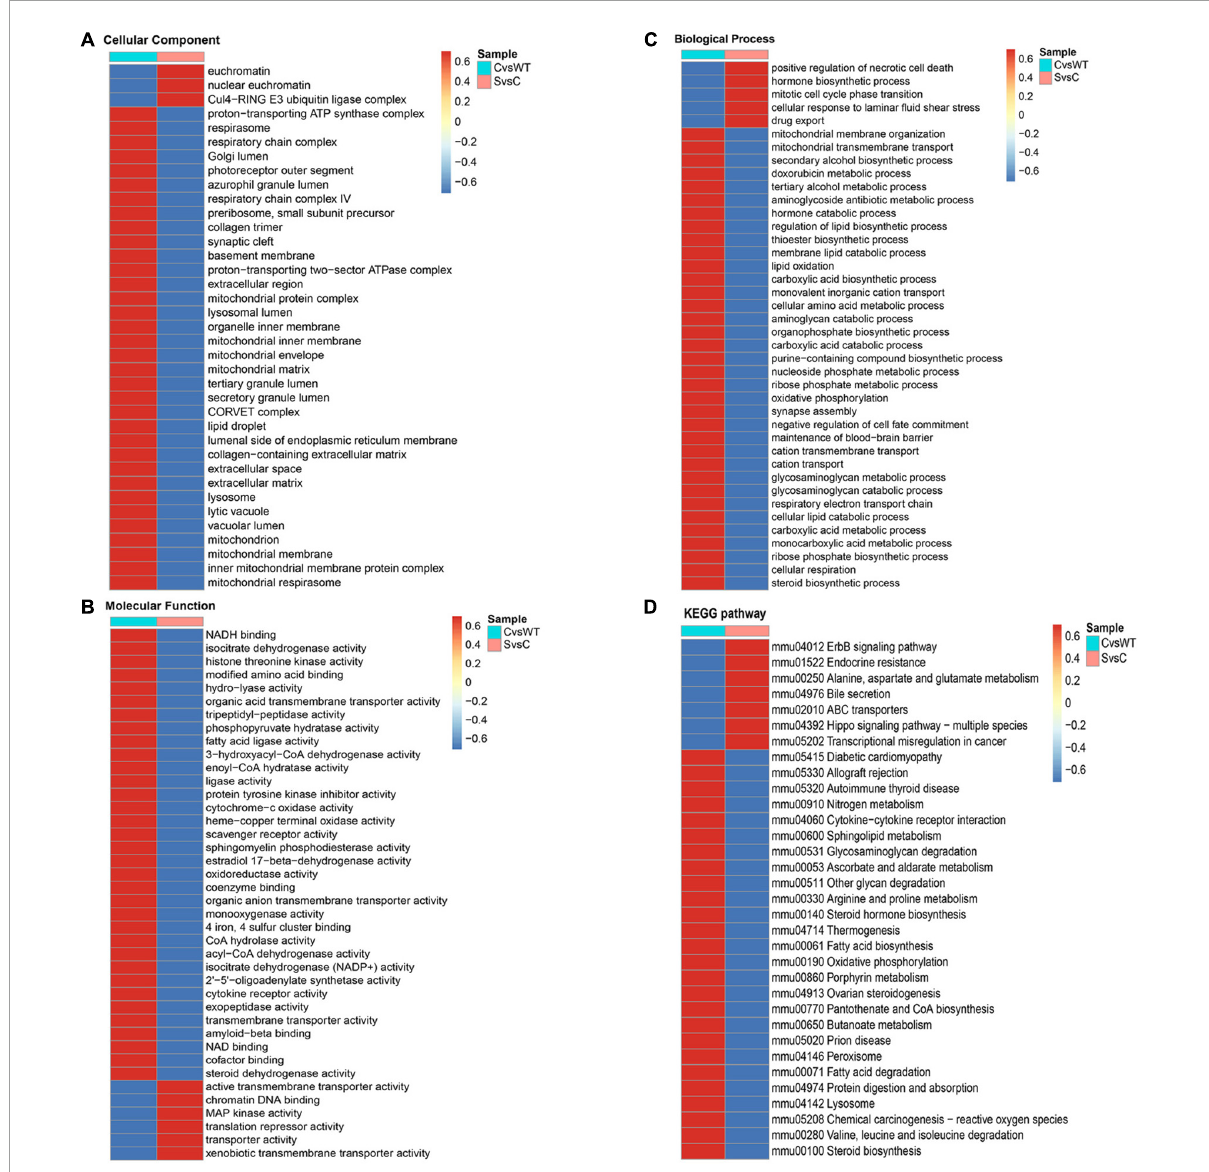
FIGURE7 GO enrichment cluster analysis and KEGG pathways cluster analysis of differentially expressed proteins (DEPs) between C/WT and S/C group. (A) GO enrichment cluster analysis of DEPs based on cell component. (B) GO enrichment cluster analysis of DEPs based on molecular function. (C) GO enrichment cluster analysis of DEPs based on biological process. (D) KEGG pathway enrichment cluster of DEPs. WT, NSC34-hSOD1WT cells. C, NSC34-hSOD1G93A cells. S, NSC34-hSOD1G93A cells treated with 100 nM ET-1.